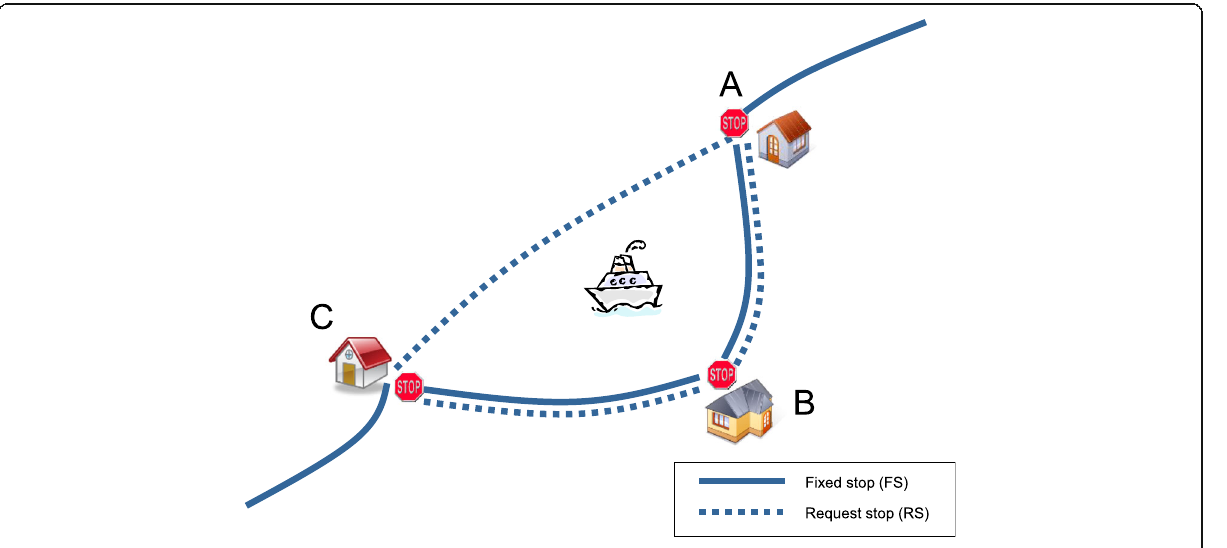
Fig. 1 Place B switches from a fixed stop to a request